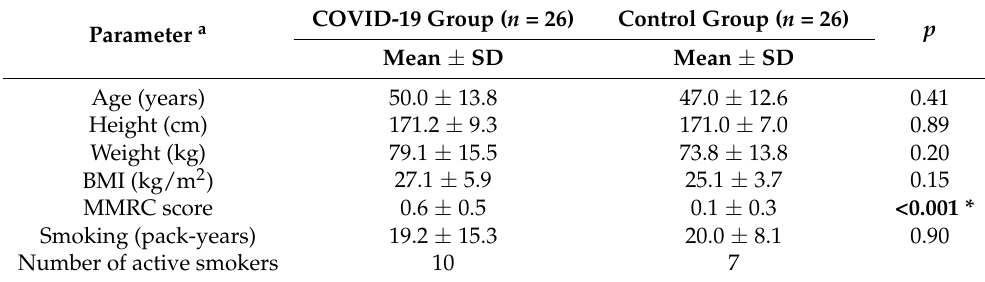
Table 1. Physical and demographic characteristics and dyspnea in COVID-19 and control groups.